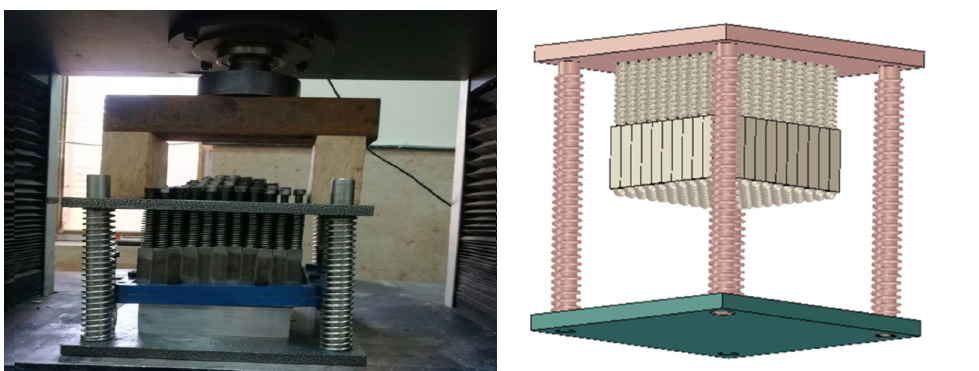
Fig. 3. multi-point forming die.